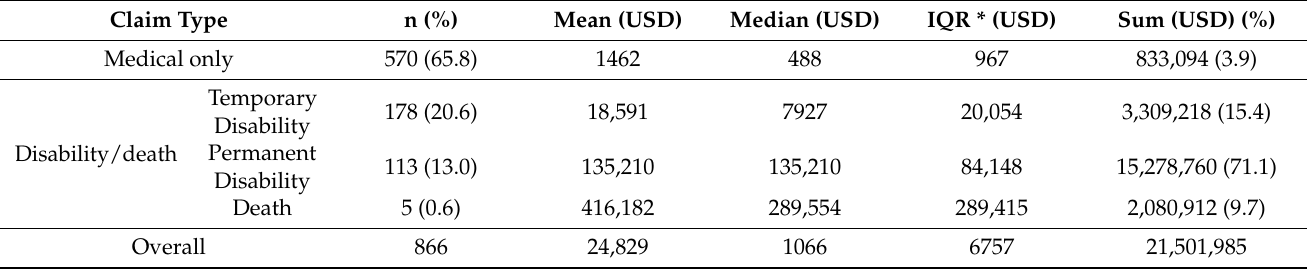
Table 3. Total cost incurred for WC payable claims by claim type (n =